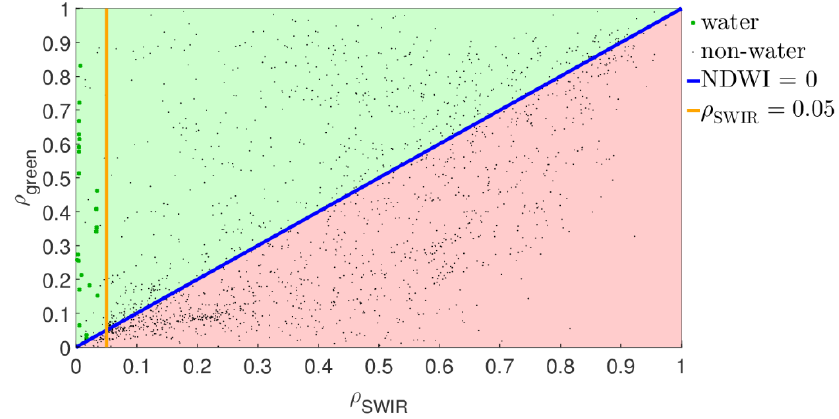
Figure 4. Scatter plot of all the water and non-water spectra in the USGS spectral library.